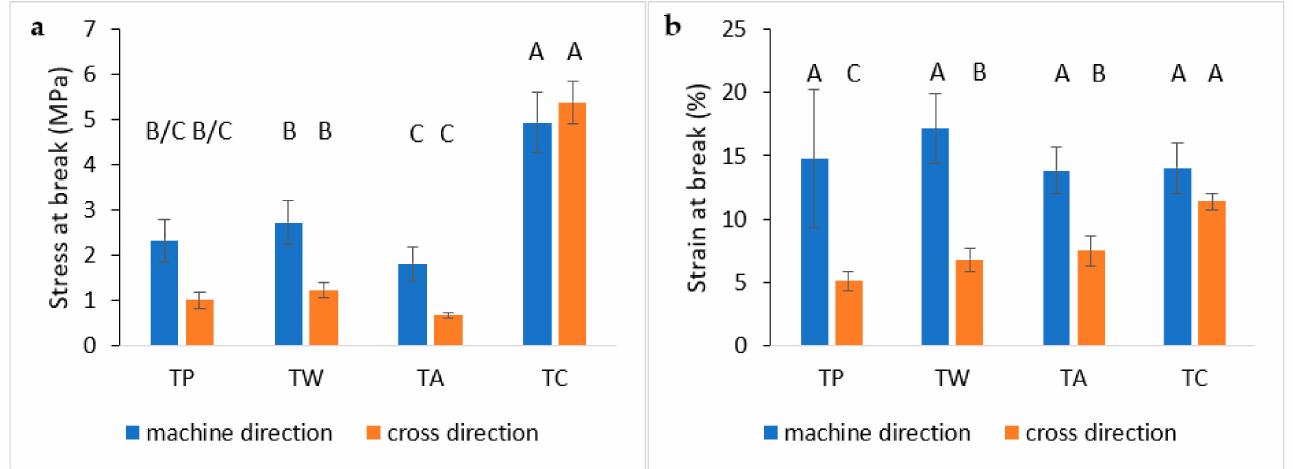
Figure 10. Stress ( a ) and strain ( b ) at break of treated and untreated tissues for tensile test. Significance of standard deviation was investigated with a Tukey HSD post hoc test performed on 5 different specimens. On the top of each column, a letter was reported. Means that were identified as not significantly different were grouped under the same